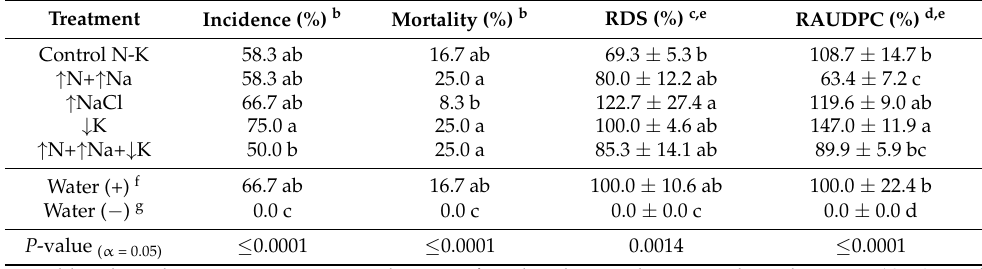
Table 3. Disease-related parameters for olive plants treated and inoculated with V. dahliae isolate V323 a .